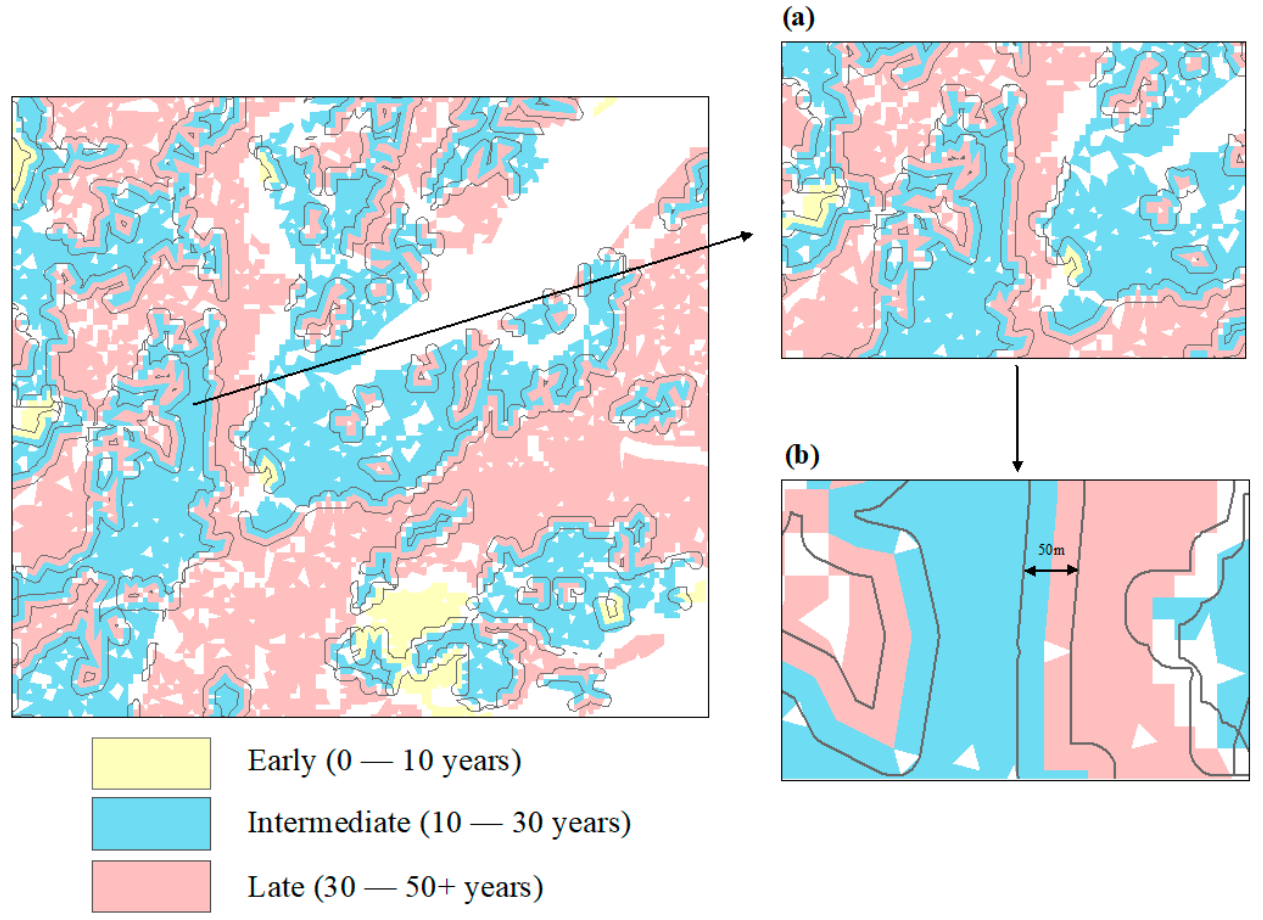
Figure 5. Transitions were extracted by building a 25 m buffer from the forest age map, which was defined into three principal successional stages according to age [23]. To improve the accuracy and reasonability of transition zone extraction, some forest patches with small areas (<5000 m 2 in early, <10,000 m 2 in intermediate, and <2000 m 2 in late) were dropped (i.e., white dots represent data gaps and strips represent invalid noise). ( a , b ) are examples and magnifications of a selected transition zone at the SRNP-EMSS, Guanacaste, Costa Rica.